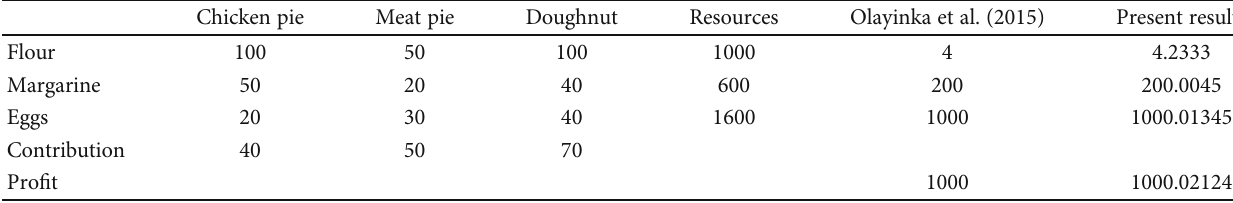
Table 4: Comparison of results of previous studies with the present study.